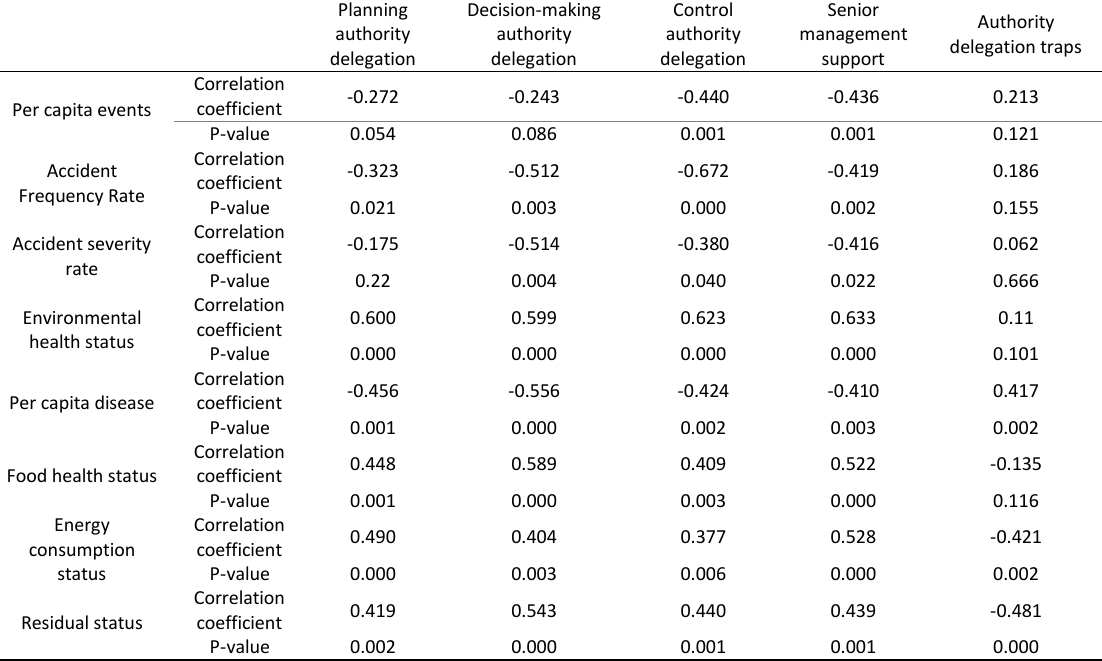
Table 3 Partial correlation between authority delegation dimensions and HSE indices .